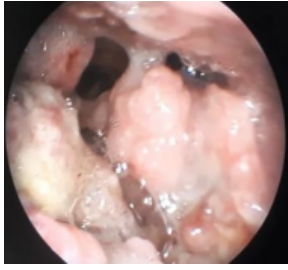
Figure 6. Ulcero-proliferative mass involving transglottis